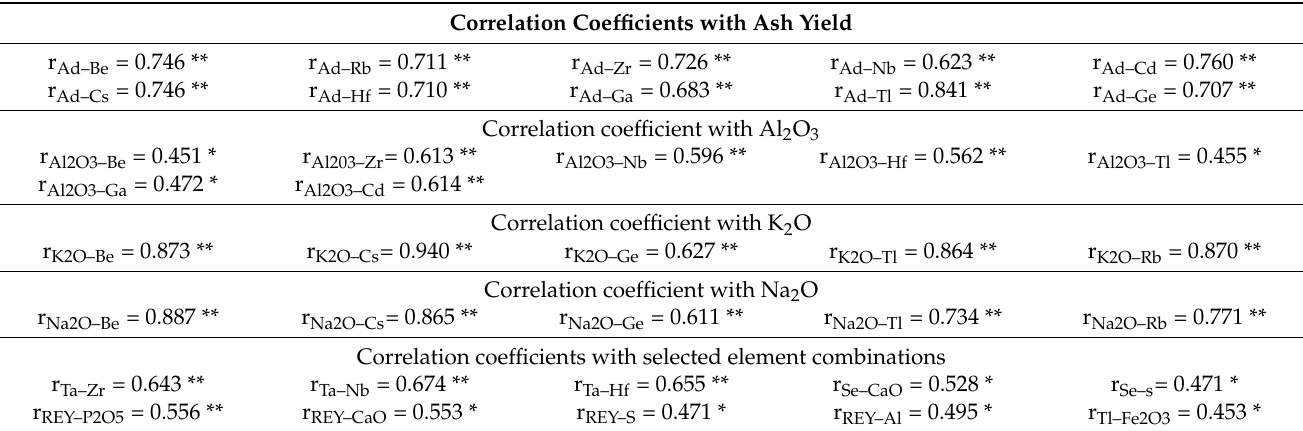
Table 5. Pearson correlation coefficient of single element and ash yield and selected elements or